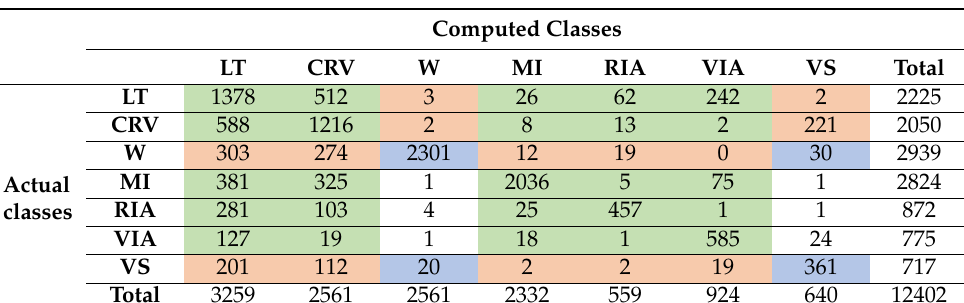
Table 1. Confusion matrix of the user behavior inference algorithm with the data obtained from the experiment of Section 4. LT refers to local task , CRV to compare real with virtual , W to walk , MI to menu interaction , RIA to real-world information assimilation , VIA to virtual information assimilation , VS to visual search . Values highlighted in green are the values where the decision to not display the guidance is well computed, values highlighted in blue are the values where the decision to display the guidance is well computed, and values highlighted in orange are the values where the decision to display or not the guidance is wrong.